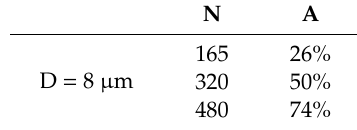
Table 2. Number of holes with diameter (D) of 7 and 8 µ m in the various fabricated caps and resulting percentage of perforated area.